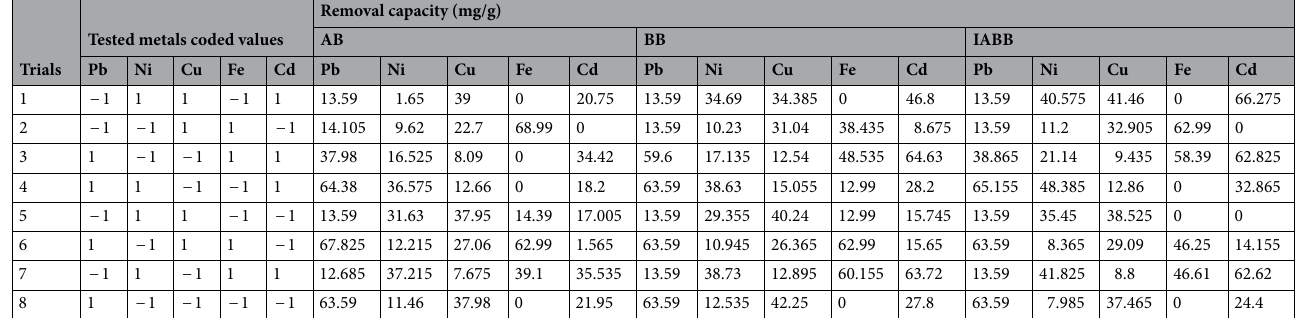
Table 1. Plackett–Burman experimental design matrix showing different combination levels of the heavy metals in the evaluation of the removal of heavy metals (mg/g) by AB, BB, and IABB.